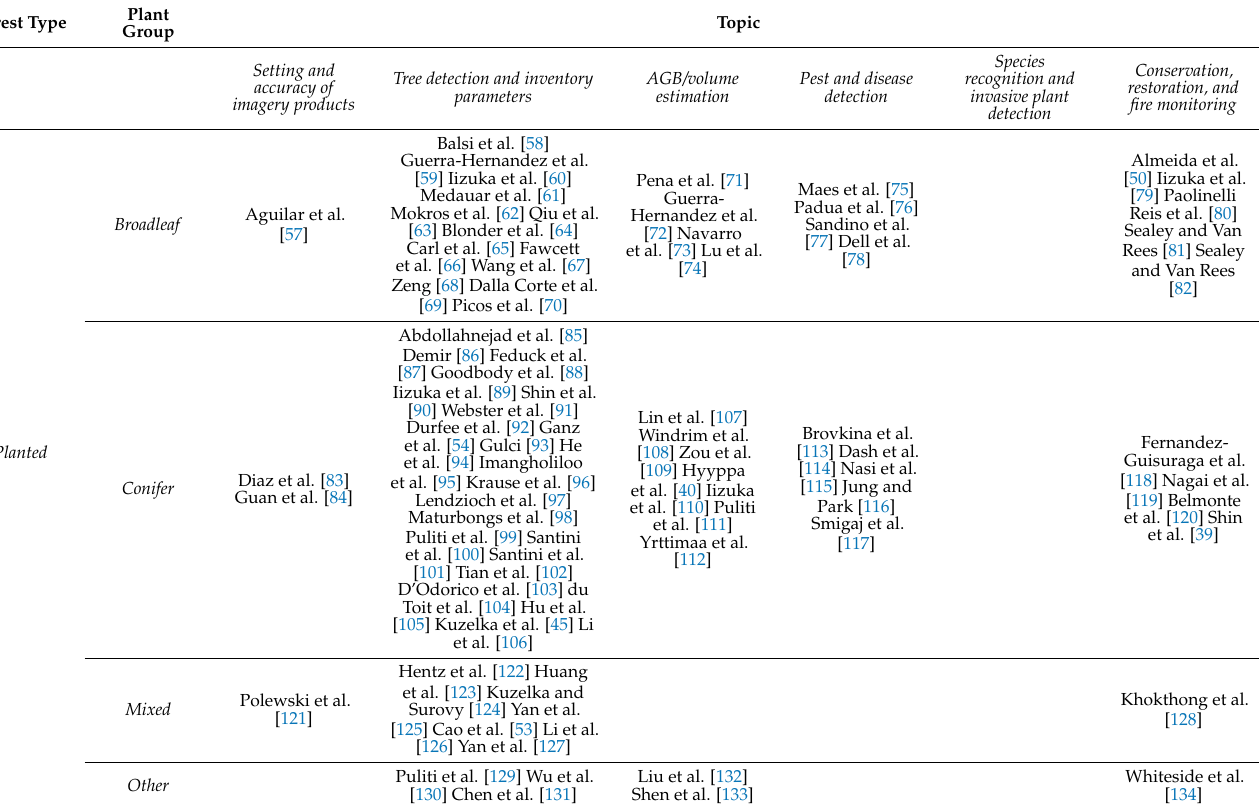
Table 1. Overall research paper dataset tabulated according to forest type, plant group, and topic. Forest